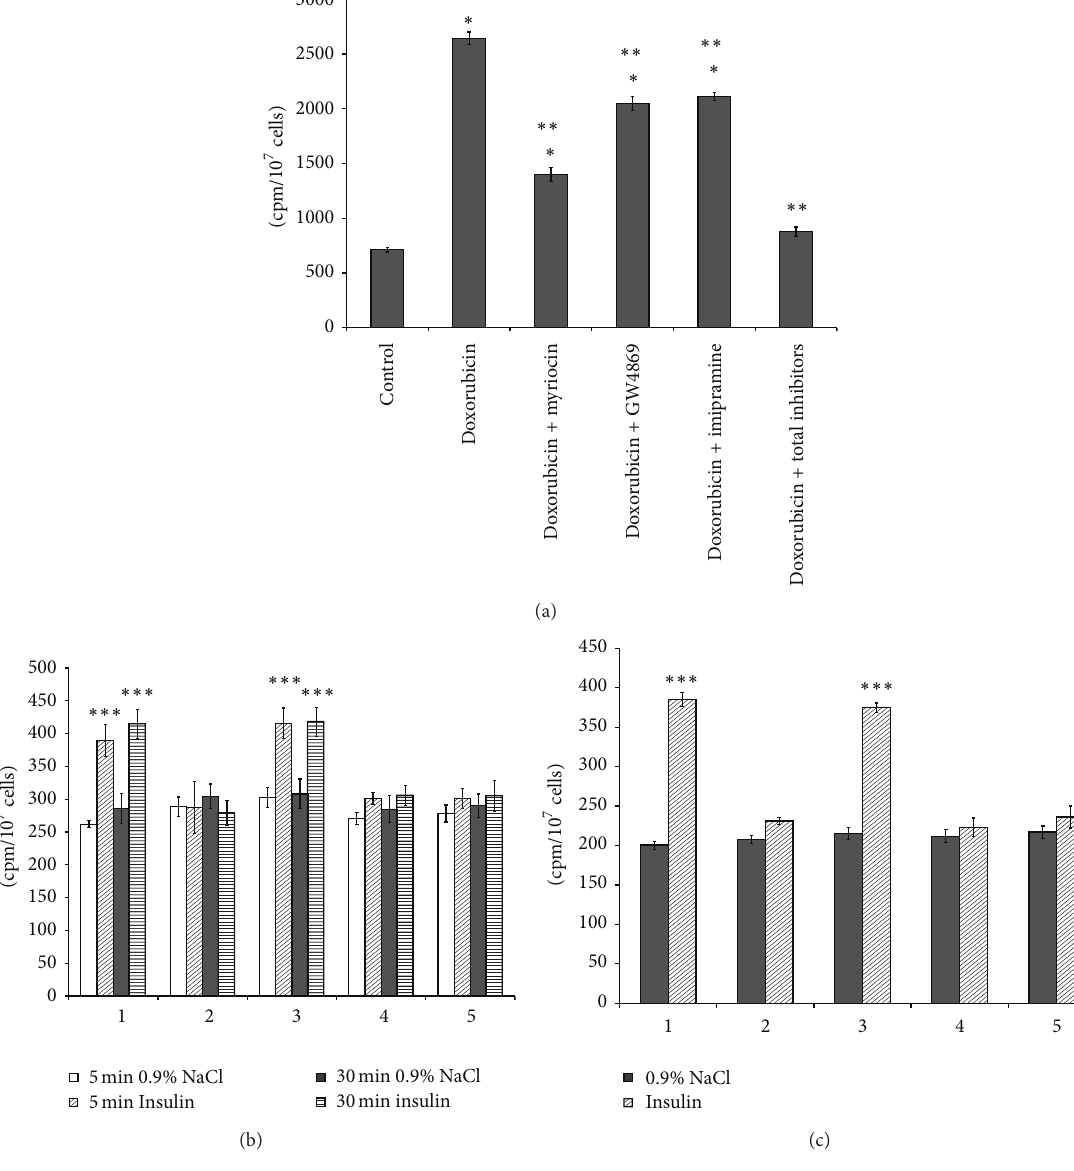
Figure 7: Effect of doxorubicin and inhibitors of sphingolipid turnover and phospholipase D activity on ceramide content and glucose metabolism stimulation by insulin in the isolated hepatocytes. (a) [ 14 C]ceramide, (b) uptake of 2-D-[ 3 H]glucose, (c) incorporation of D-[U 14 C]glucose into glycogen. 1: cells treated with DMSO (control cells); 2: doxorubicin; 3: doxorubicin + total sphingolipid turnover inhibitors; 4: doxorubicin + total sphingolipid turnover inhibitors + halopemide (200 nM); 5: doxorubicin + total sphingolipid turnover inhibitors + halopemide (300 nM). Effect of insulin on phospholipase D activity and glucose metabolism in drug-pretreated hepatocytes was determined as described in the Methods. ∗ 𝑝 < 0.05 , doxorubicin versus control; ∗∗ 𝑝 < 0.05 , doxorubicin + drug versus doxorubicin; ∗∗∗ 𝑝 < 0.05 , insulin versus